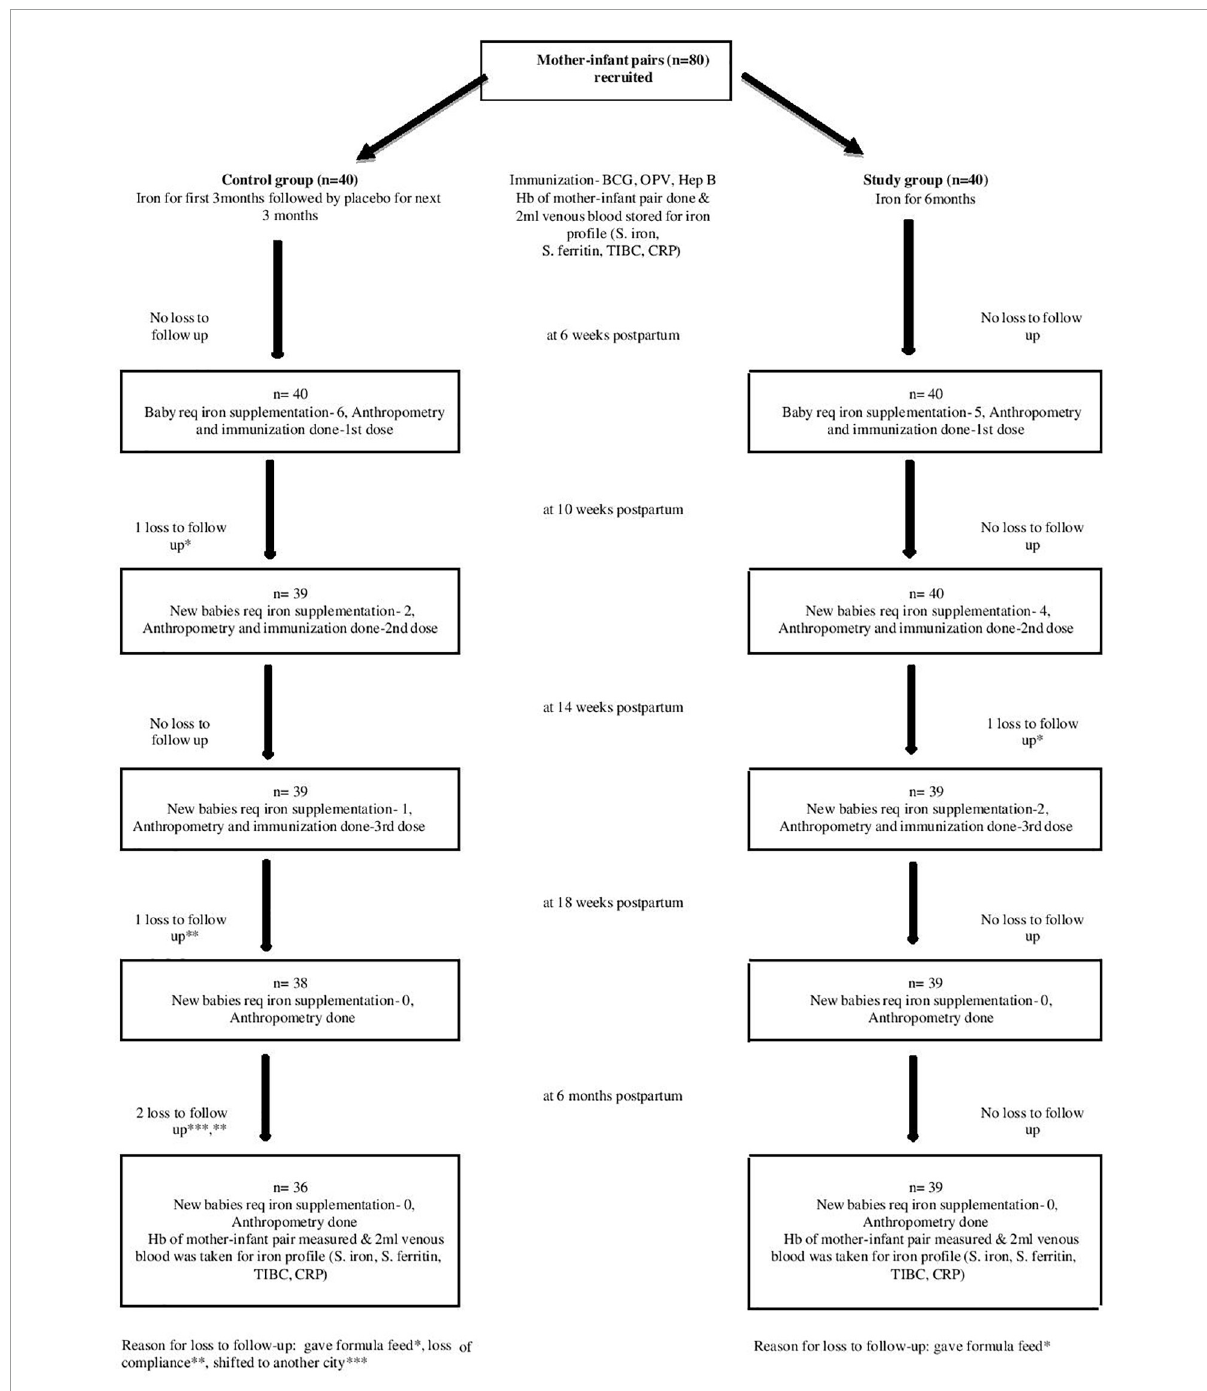
FIGURE1 Study flow chart.